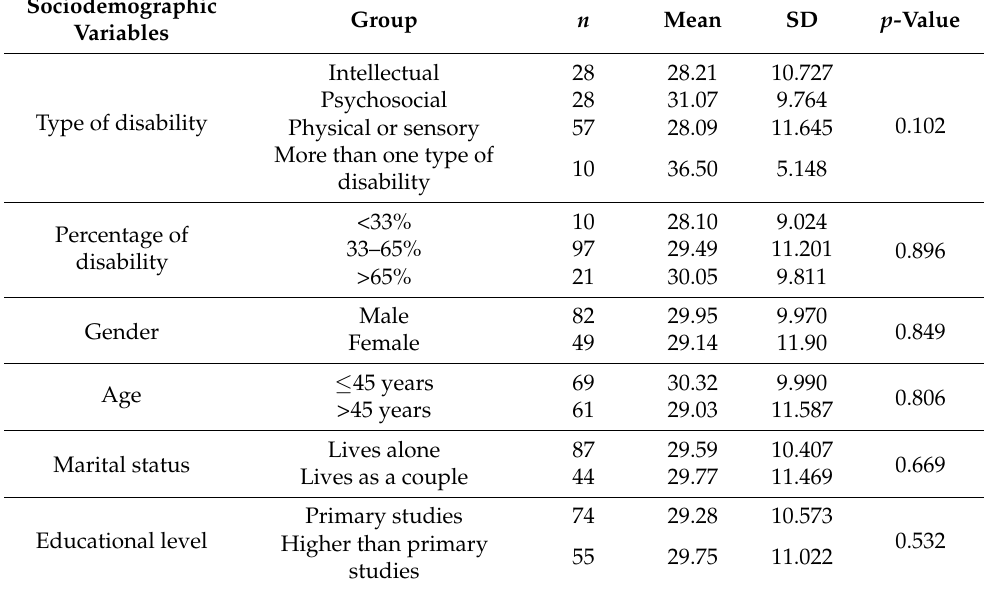
Table 4. Differences between groups in the primary outcome variable “personal efficacy” using ANOVA and Mann–Whitney U